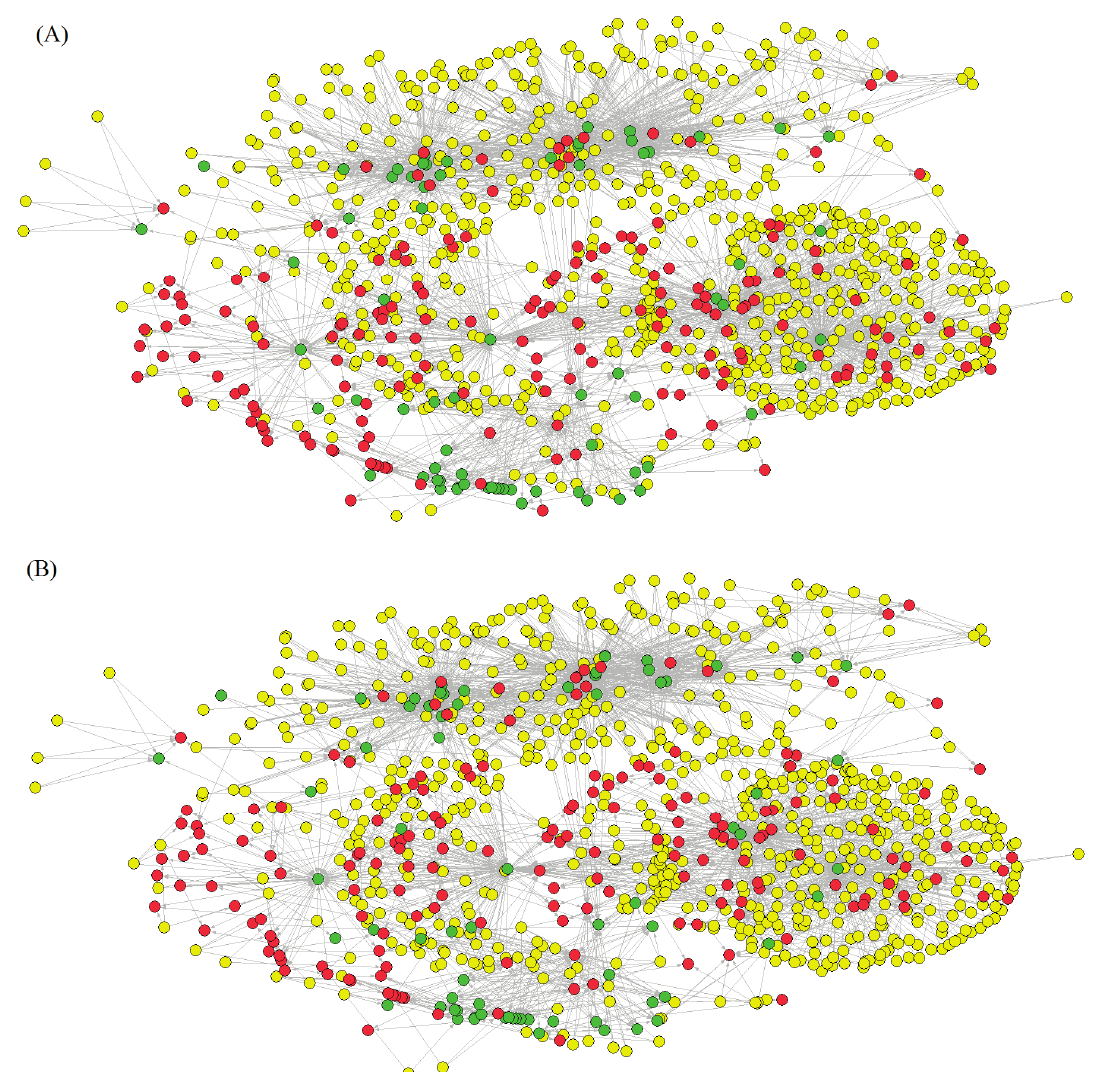
Figure 1. Multitarget, Multiscale, and Multi-output networks, of CHEMBL sub-set of neuroprotection related drugs (yellow), targets (red), and pharmacological assays (green) Observed ( A ) vs . Predicted ( B